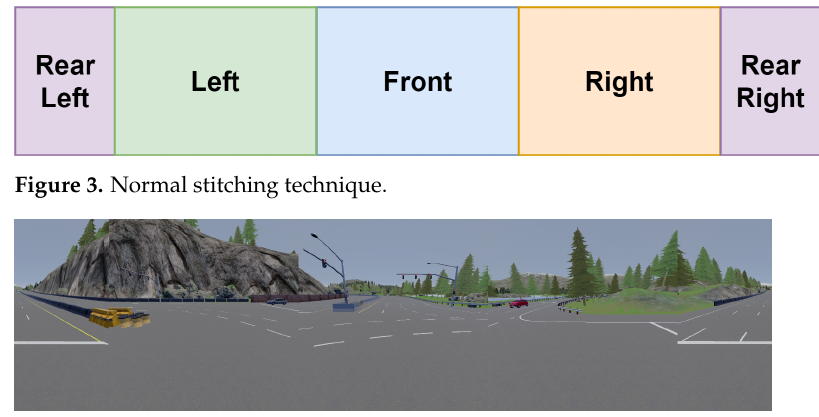
Figure 4. Normal stitching example.